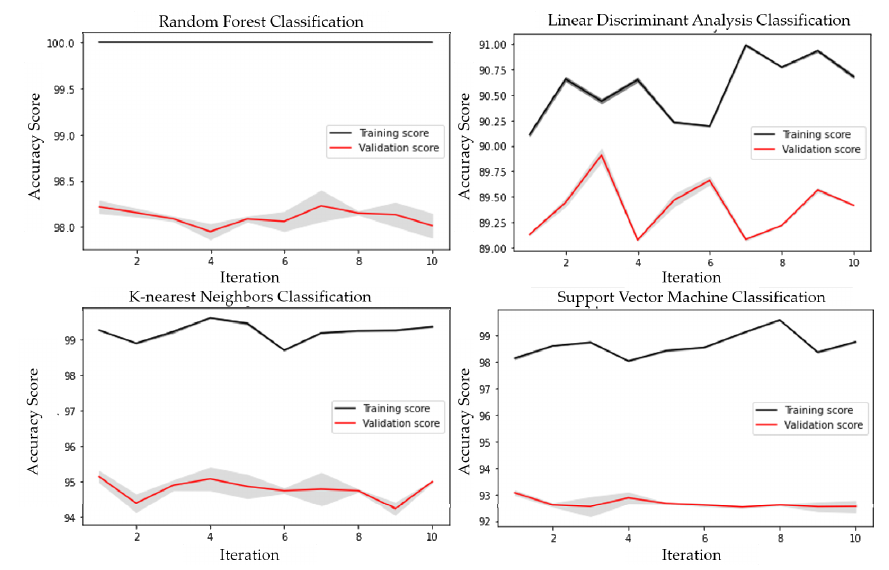
Figure 17. The evaluation of model performance using the NCV method.